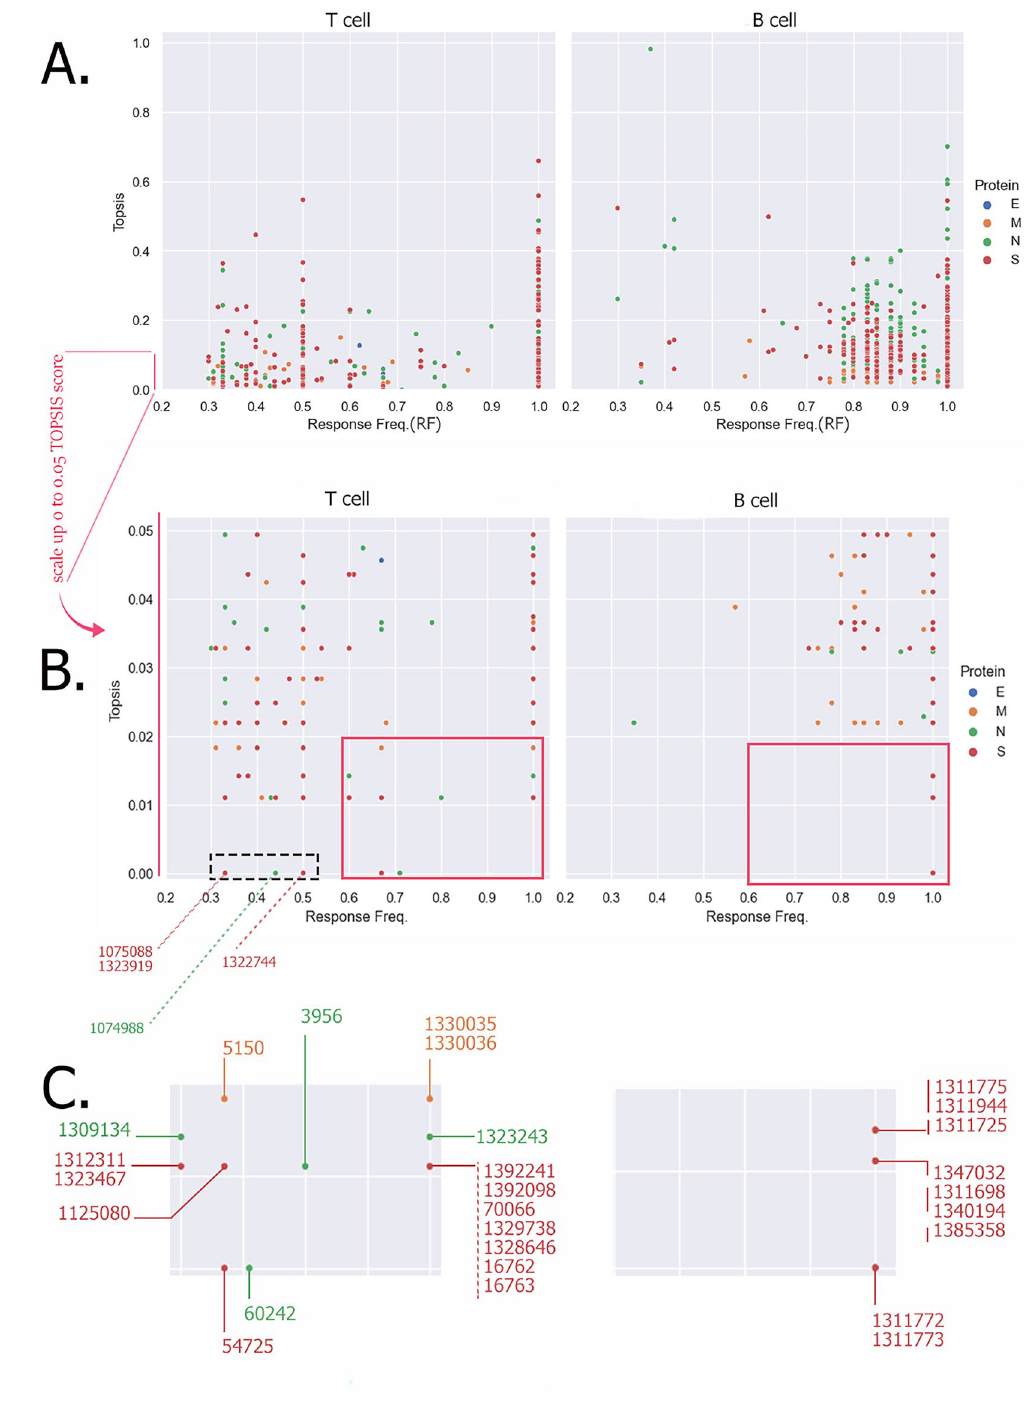
Figure 7. ERTP illustrates IEDB B cell and T cell epitopes immunologic property (by RF) along with conservity by TOPSIS scoring. In Panel ( A ) a logical comparison between IEDB epitopes has made through TOPSIS score (vertical axis) and Response Frequency (horizental axis). It helps to understand difference between IEDB epitopes with the same number of events but a distinct number of mutated sites. Panel ( B ) scales up vertical axis (TOPSIS score) for better illustration of position of different dots in the diagram. Right lower quadrant presents epitopes with higher immunologic properties besides higher conservity (the red boxes). In panel ( C ) red boxes are magnified and ID of each epitope (dot) is noted. It should be note that some dots represent for several epitopes with the same RF and TOPSIS